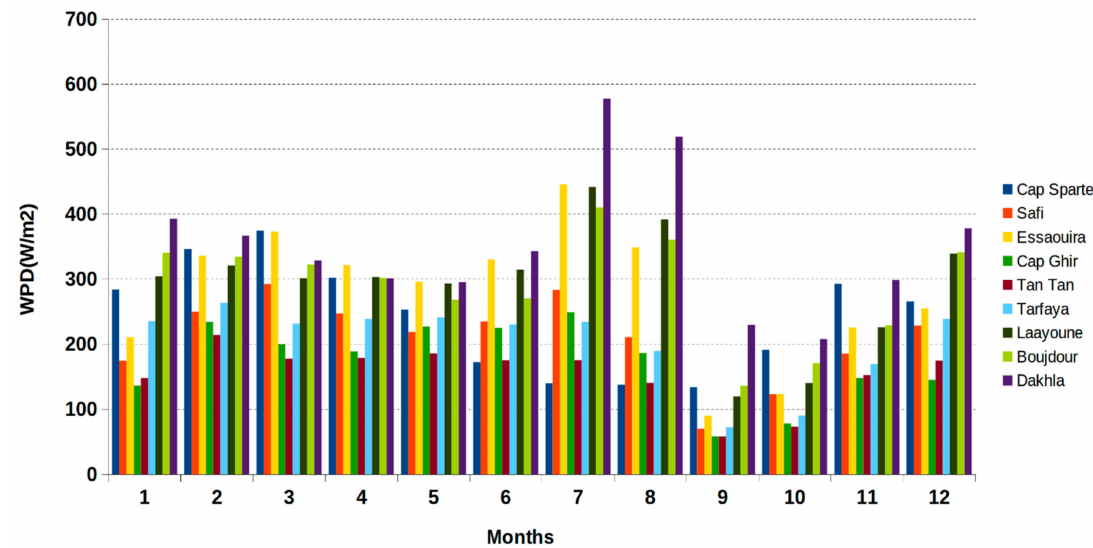
Figure 12. Climatological monthly variation of the WPD along each selected